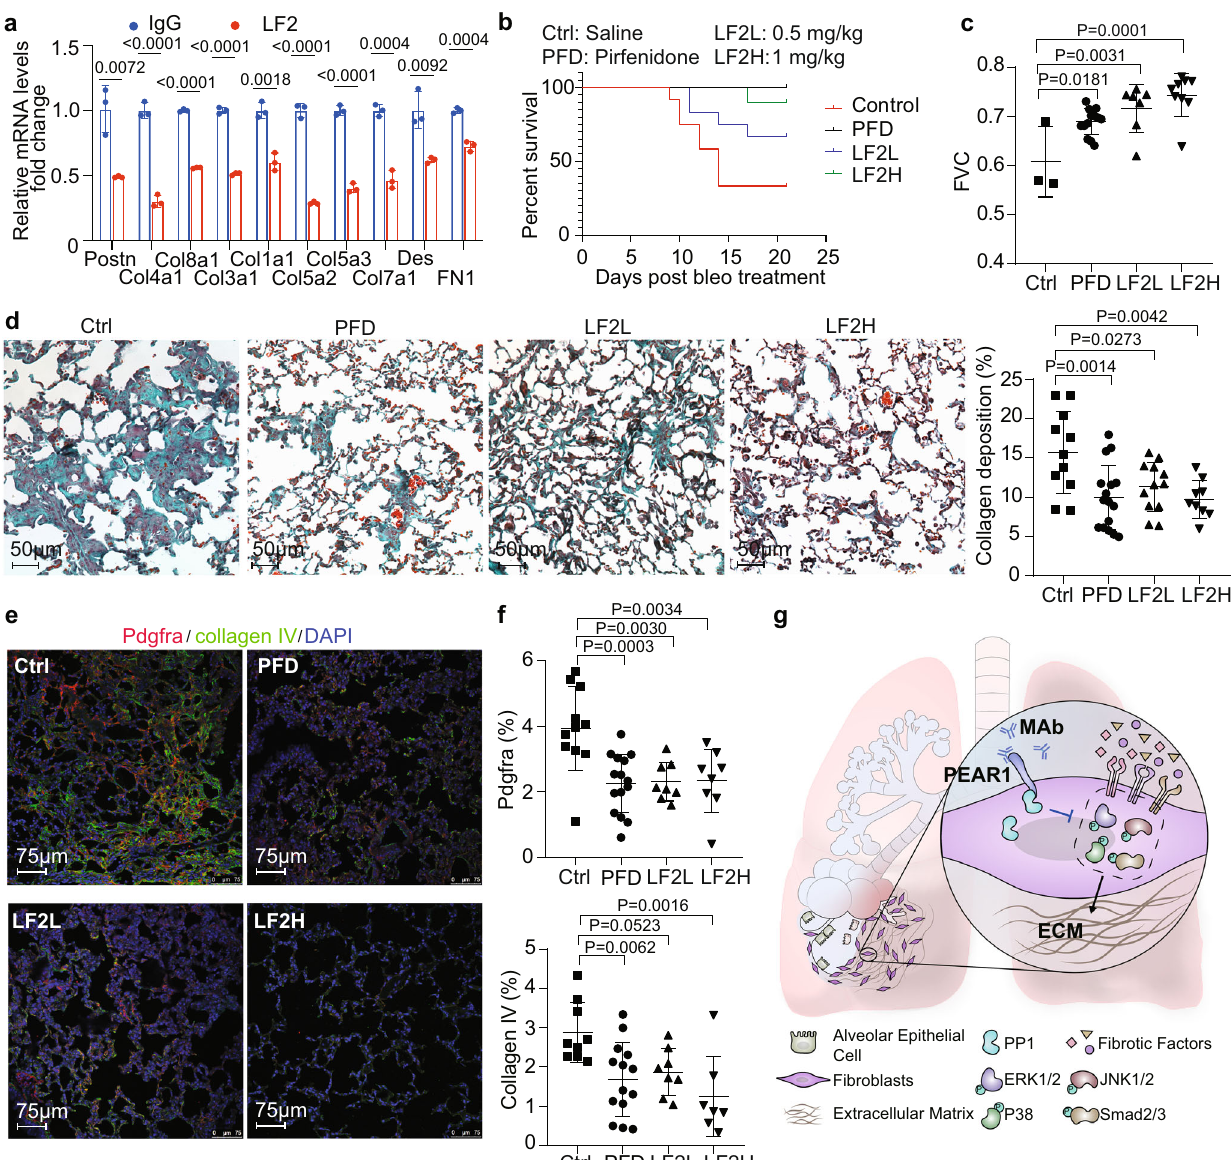
Fig. 4 | Monoclonal antibody targeted human PEAR1 for PF therapy. a The mRNA expression levels of extracellular matrix genes in human pulmonary fi bro- blasts (HFL1) treated with 1 µ g/mL anti-human PEAR1 monoclonal antibodies (LF2) byqPCR( n =3biologicallyindependentsamplesineachgroup).LF2isahumanized antibodywithanADCC/ADCP-weakhumanIgG4FcwithS228Pmutation. b Survival curves of humanized Pear1 mice induced by 1.5 µ g/g (body weight) bleo treated with 300mg/kg pirfenidone daily by gavage (PFD), 0.5mg/kg (LF2L), 1mg/kg (LF2H)LF2throughthetracheaonceaweek.Salinewasusedascontrol(Ctrl)( n =11 mice in Ctrl group; n =16 mice in PFD group; n =12 mice in LF2L group and n =10 miceinLF2Hgroup). c FVCwasmeasuredofCtrlgroupmice,PFDgroupmice,LF2L group mice, and LF2H group mice ( n =3 mice in Ctrl group; n =11 mice in PFD group; n =7 mice in LF2L group; n =9 mice in LF2H group). d Representative imagesofmassonstainingonlungsectionsfromCtrlgroupmice,PFDgroupmice,